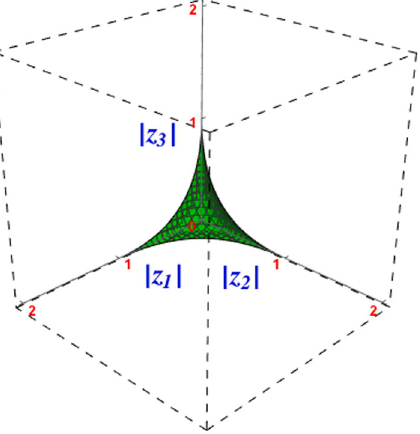
Fig. 3 Convergence region of the r.h.s. of Eqs. (2) and (4) in the first and fifth octants of the real ( z 1 , z 2 , z 3 )